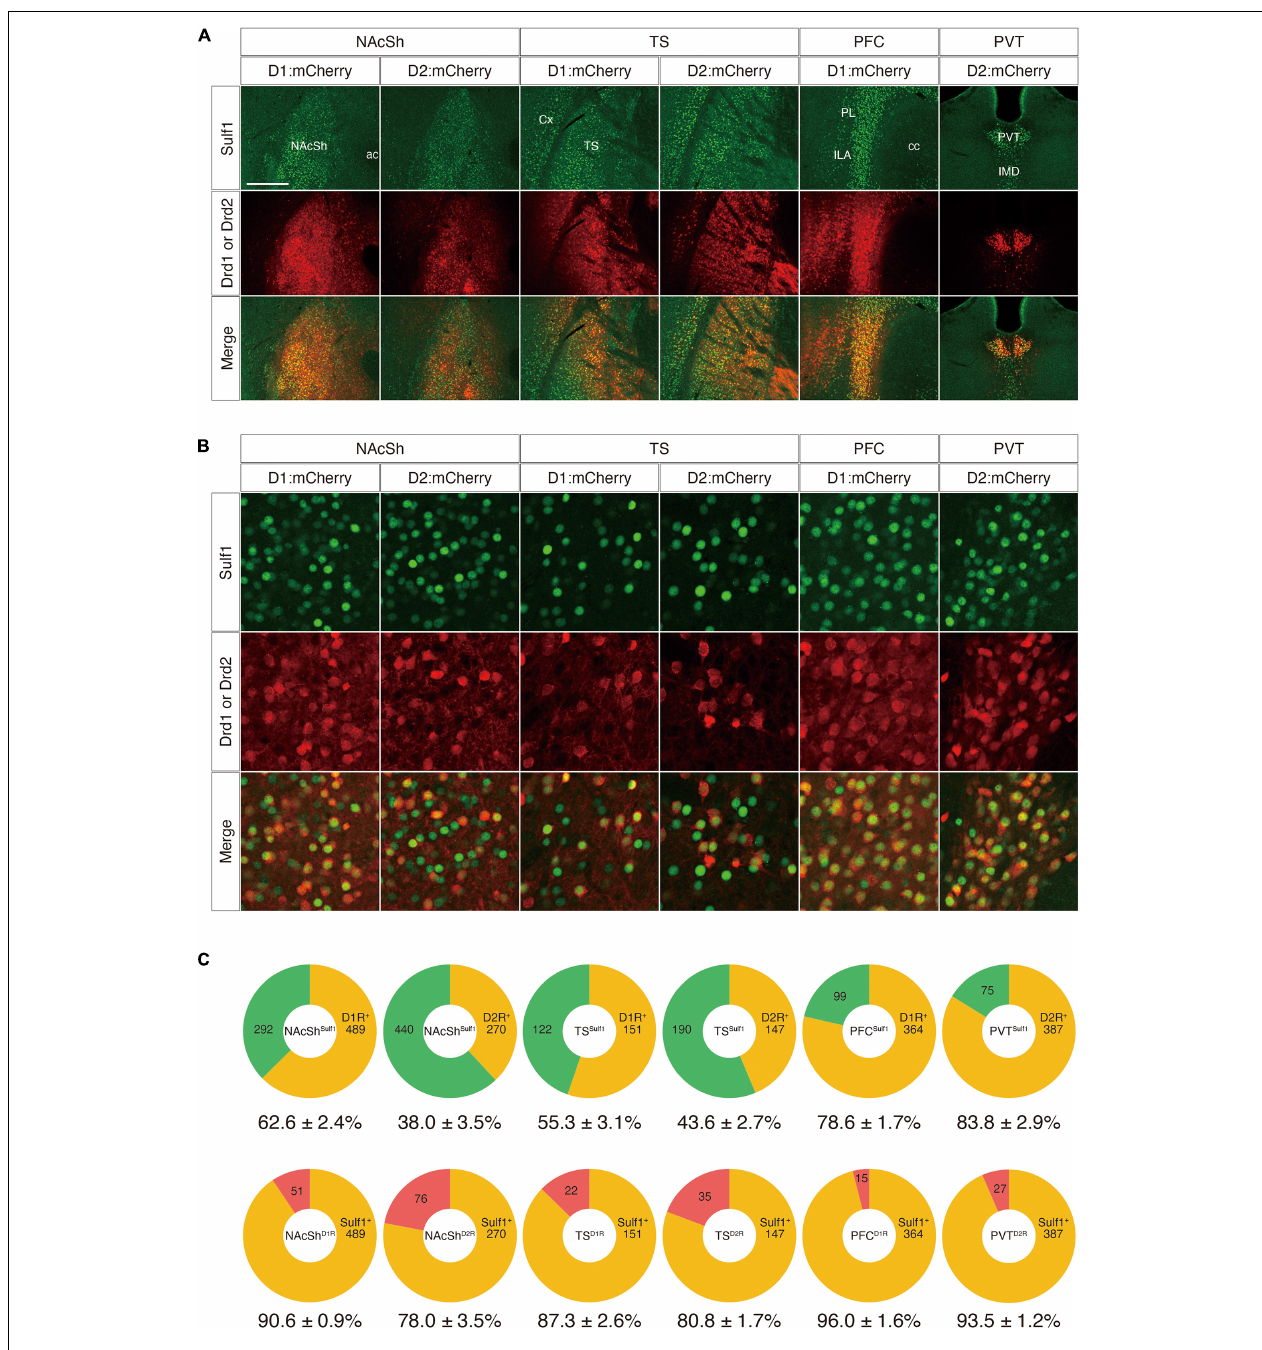
FIGURE 9 | Co-expression of Sulf1 and the dopamine D1/D2 receptors. (A) Confocal microscopic images of the coronal brain slices. Sulf1 -expressing cells were identified by detection of β -galactosidase inserted in the Sulf1 locus ( Sulf1 lacZ / + mice). To label the D1R- or D2R-expressing neurons, AAV5-hSyn-DIO-mCherry was injected into the specific brain regions of the mice carrying Drd1-Cre or Drd2-Cre transgenes. The signals for β -galactosidase (green) and mCherry (red) are shown. The yellow signals in the merged images indicate co-localization. Coronal slices of the nucleus accumbens shell (NAcSh), posterior tail of the striatum (TS), prefrontal cortex (PFC), and paraventricular nucleus of the thalamus (PVT) are shown. ac, anterior commissure; cc, corpus callosum; Cx, cerebral cortex; ILA, infralimbic area; IMD, intermediodorsal nucleus of the thalamus; PL, prelimbic area. (B) High magnification images of the NAcSh, TS, PFC, and PVT regions are shown. (C) The upper panels show the percentages of D1R- or D2R-positive (orange) and D1R- or D2R-negative (green) cells in the Sulf1 -expressing cells in each region. The lower panels show the percentages of Sulf1 -positive (orange) and Sulf1 -negative (red) cells in the D1R- or D2R-expressing cells in each region. Cell counting was conducted for three randomly selected ROIs for all regions from three mice (NAcSh) and two mice (other regions). The numbers in the circular graphs indicate the number of cells in each category. The numbers below the graphs indicate the percentages of co-localization. The scale bars indicate 400 µ m in (A) and 50 µ m in (B) . Approximate AP levels from the bregma (in mm) in (A,B) are 1.0 (NAcSh), –1.0 (TS, PVT), and 2.0